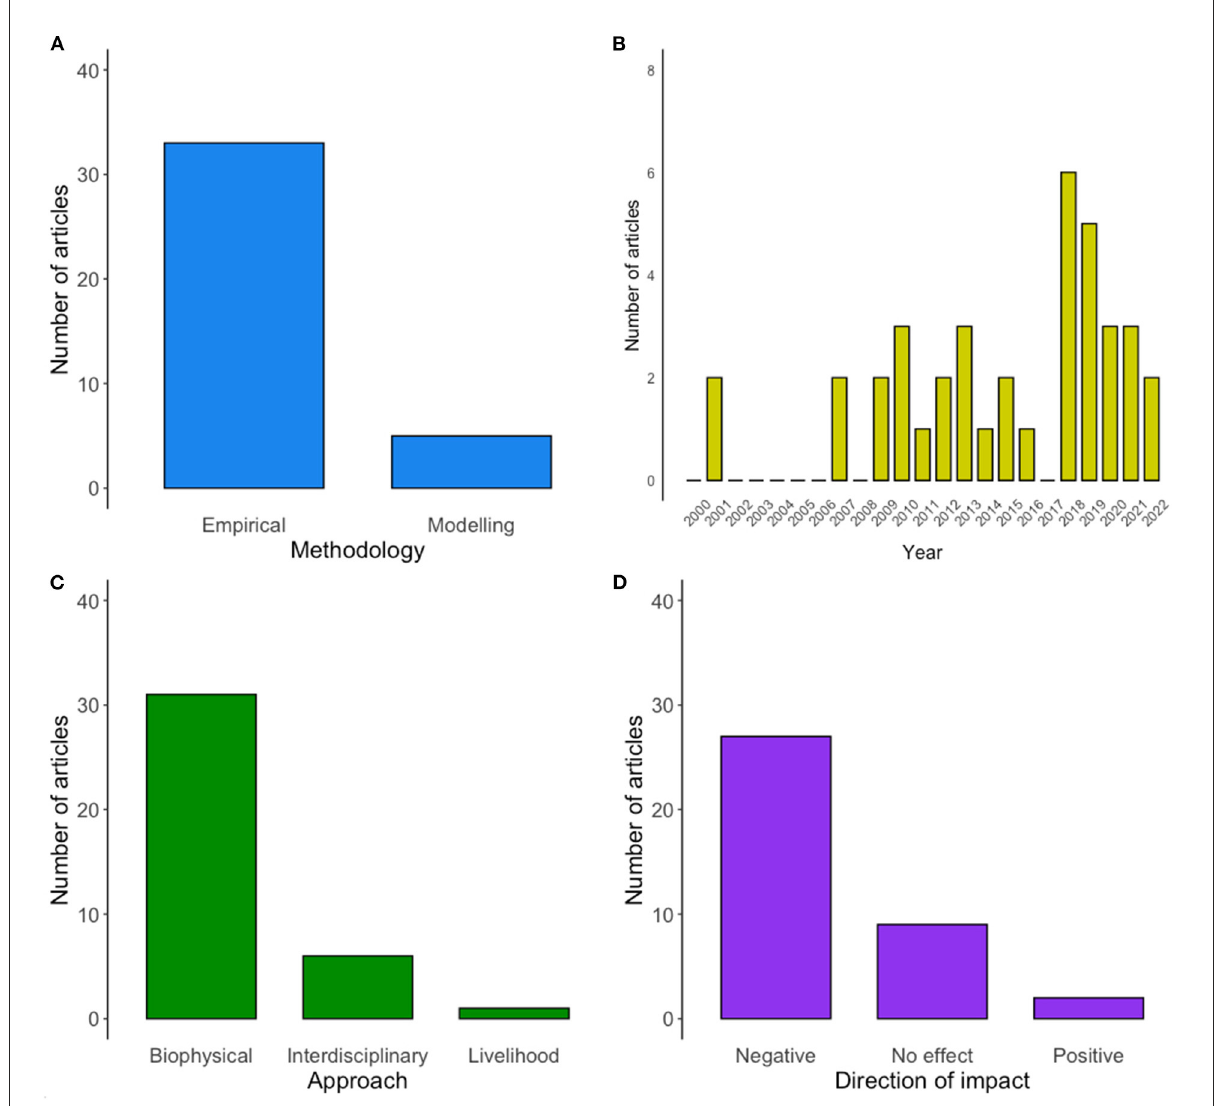
FIGURE3 Number of published articles globally on the impacts of climate change by (A) methodology, (B) year starting from 2000, (C) approach, and (D) direction of impact